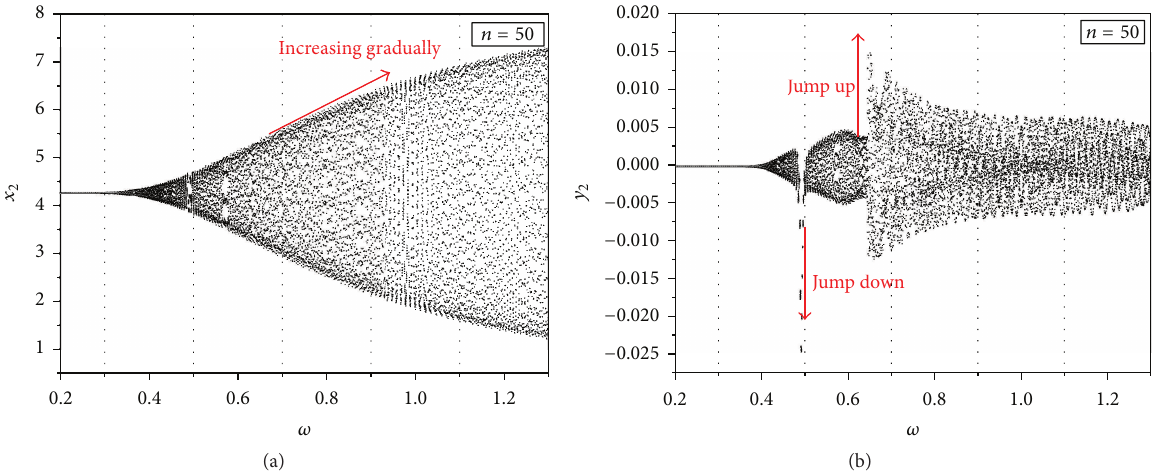
Figure 15: Steady-state response of displacement when 𝑛 = 50 : (a) 𝑥 2 and (b) 𝑦 2